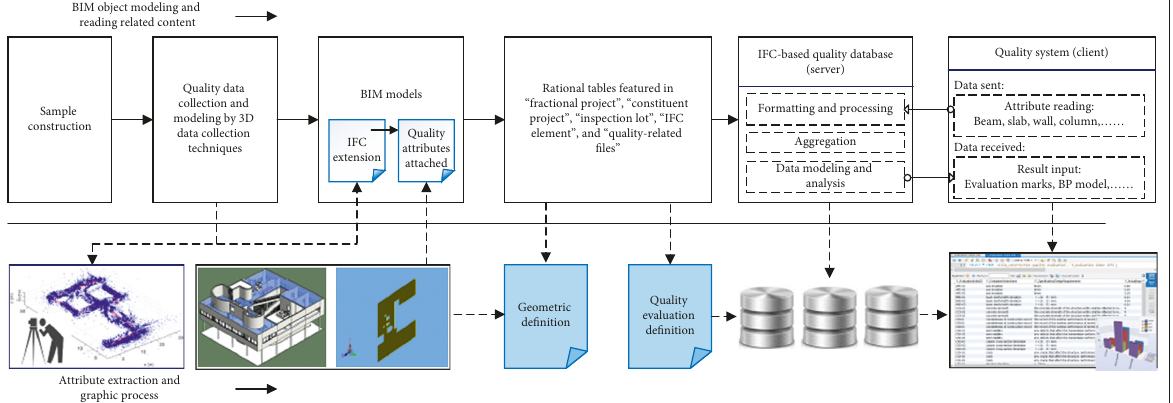
Figure 10: E-R diagram for quality evaluation